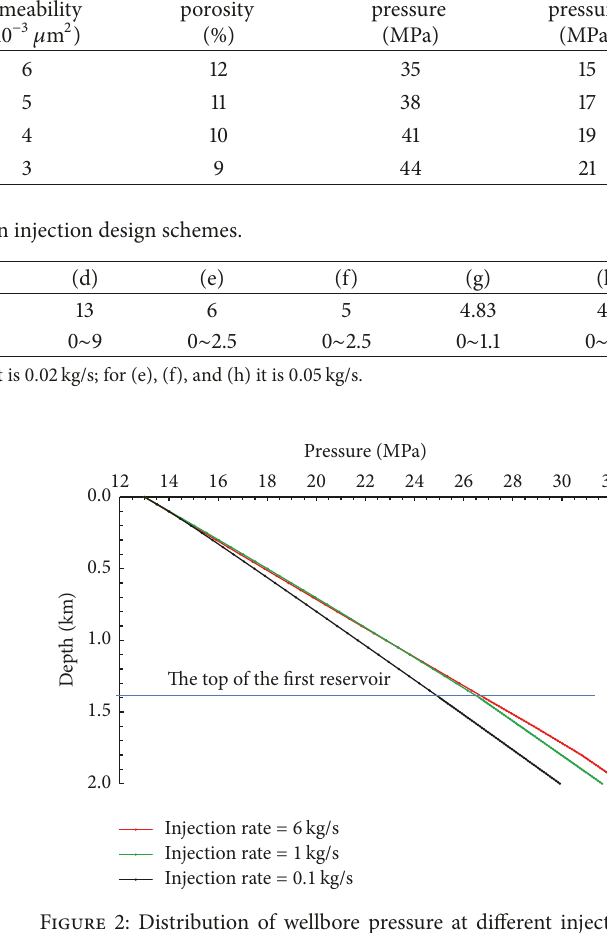
Figure 2: Distribution of wellbore pressure at different injection